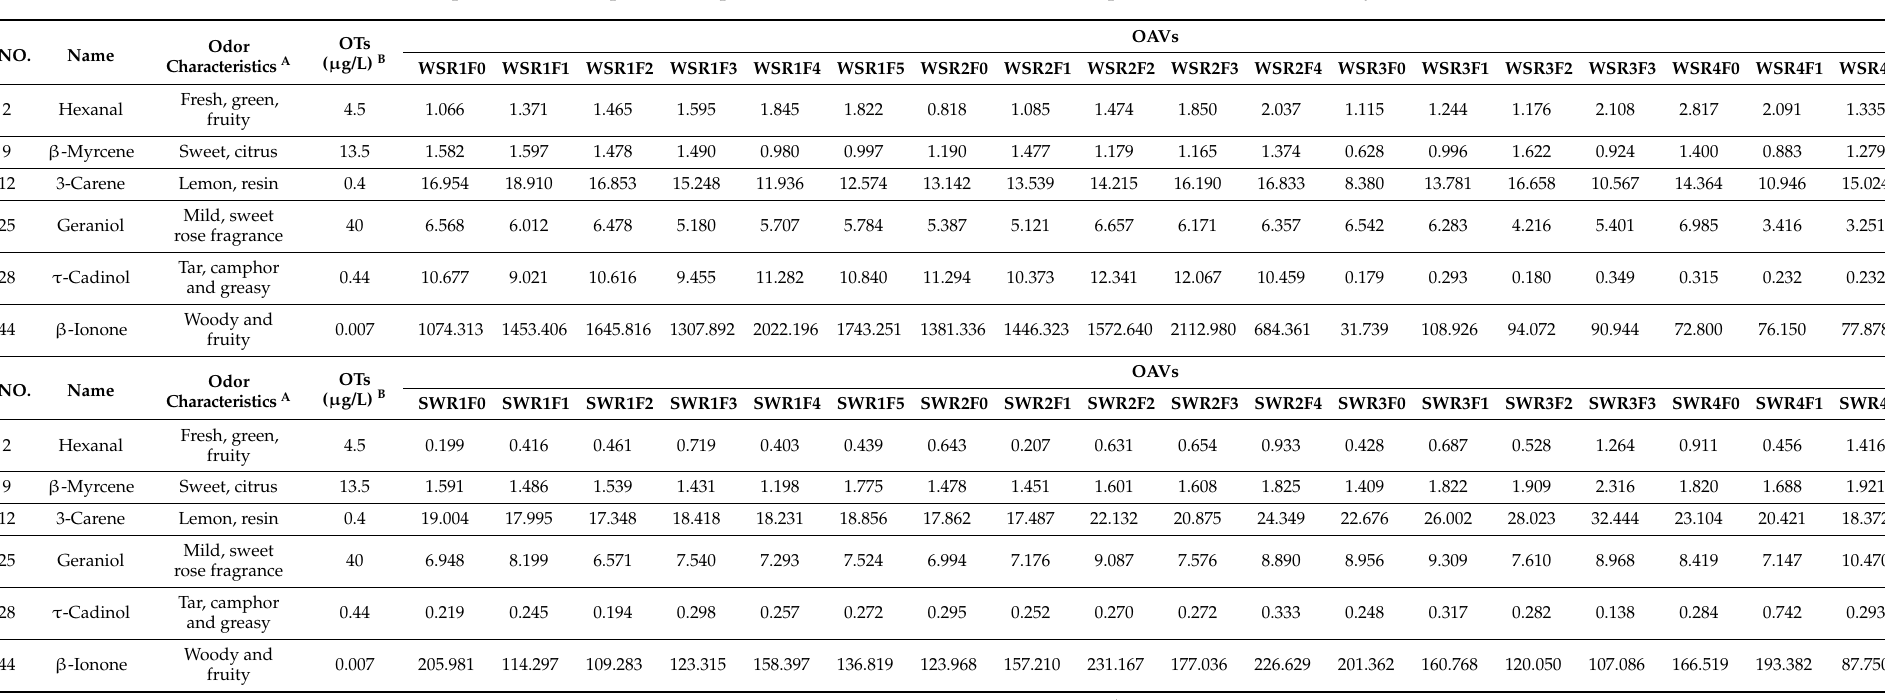
Table 1. Principal volatile compounds responsible for aroma of the black tea samples and their odor activity values